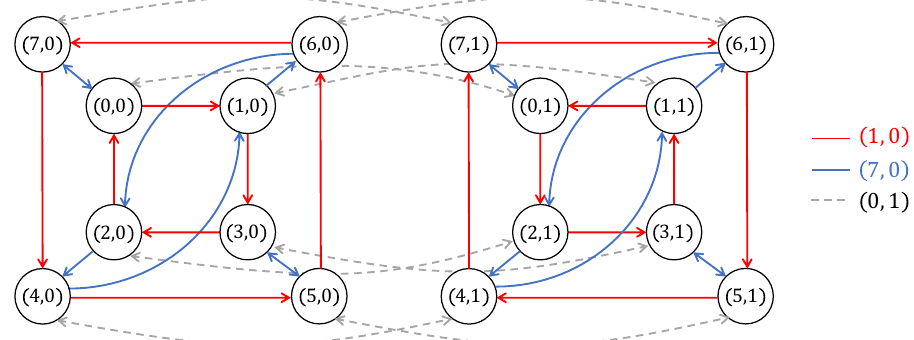
Figure 3. The right Cayley graph C 1 = RCay ( Dih ( G 8 ) , (cid:101) S 1 ) , where S 1 = { 1,7 } , in Example